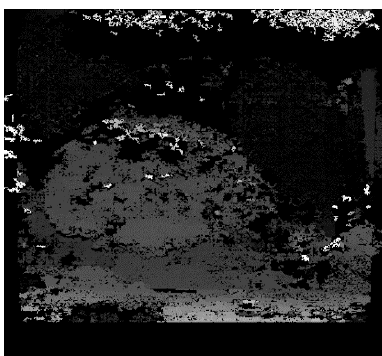
Figure 7. Left: left_image_rectified right: right_image_rectified: the rectified images from each camera